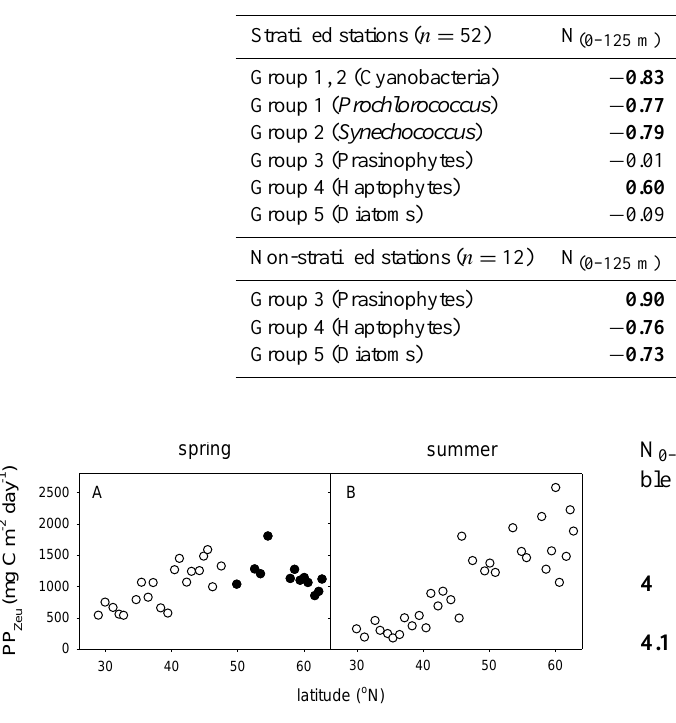
Fig. 7. Latitudinal changes in daily primary production in the eu- photic zone (PP Zeu ) during the spring (A) and summer (B) cruise. Productivity was estimated from in situ phytoplankton biomass and composition, light, light attenuation, and temperature using a bio- optical model (see Methods section for details). Black symbols rep- resent data from non-stratified